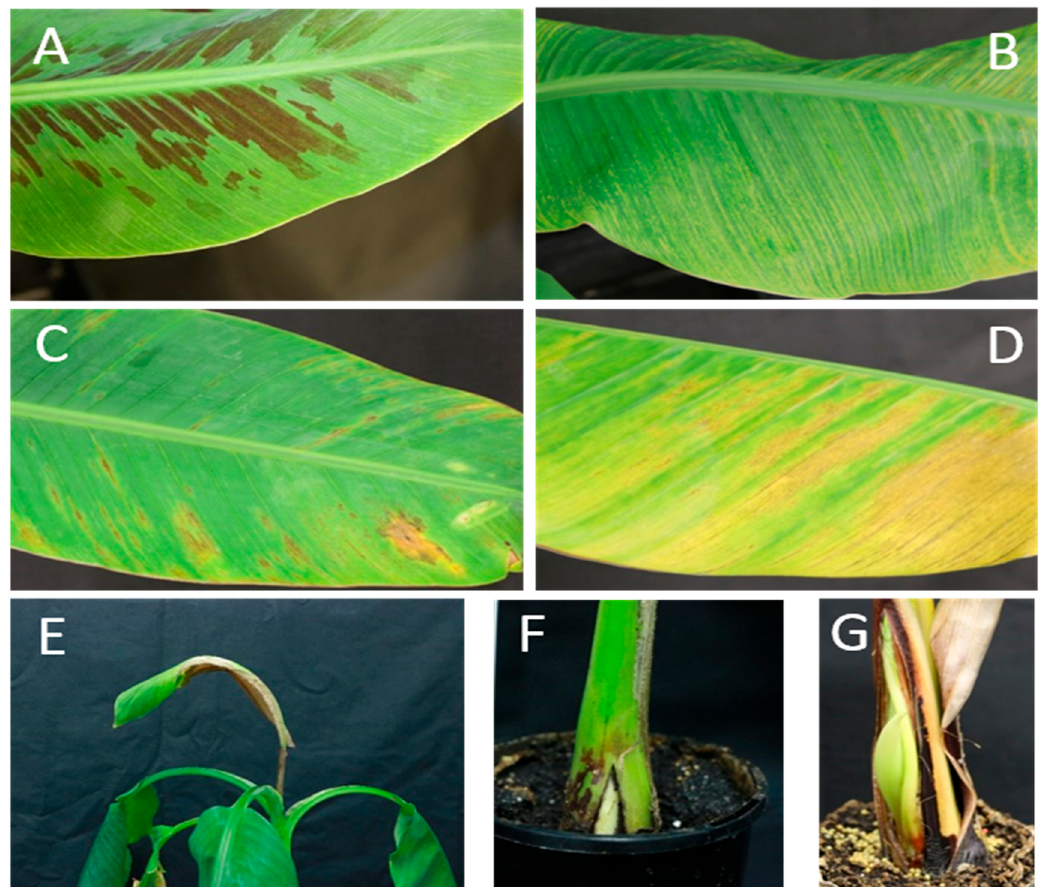
Figure 3. Inoculation of Musa acuminata bananas with pOPT-EBX-BSCAV. ( A ) Williams (Cavendish-AAA) leaf at 8 weeks showing typical mild flecking symptoms. ( B ) Pisang Madu ( Musa AA subgroup) leaf at 8 weeks showing chlorotic streaking. ( C ) Truncata ( M. acuminata subsp. Truncata (AA)) and ( D ) Igisahira Gisanzwe ( Musa AAA-East African Highland Banana subgroup) leaves at 8 weeks showing chlorotic and necrotic areas. ( E , F ) Khae Phrae ( M. acuminata AA subsp. siamea ) plants at 16 weeks showing cigar leaf necrosis and pseudostem splitting. ( G ) Igisahira Gisanzwe plant at 28 weeks showing abnormal pseudostem growth/splitting. Table 1. Host range and symptoms of the BSCAV infectious clone in Musa acuminata bananas.